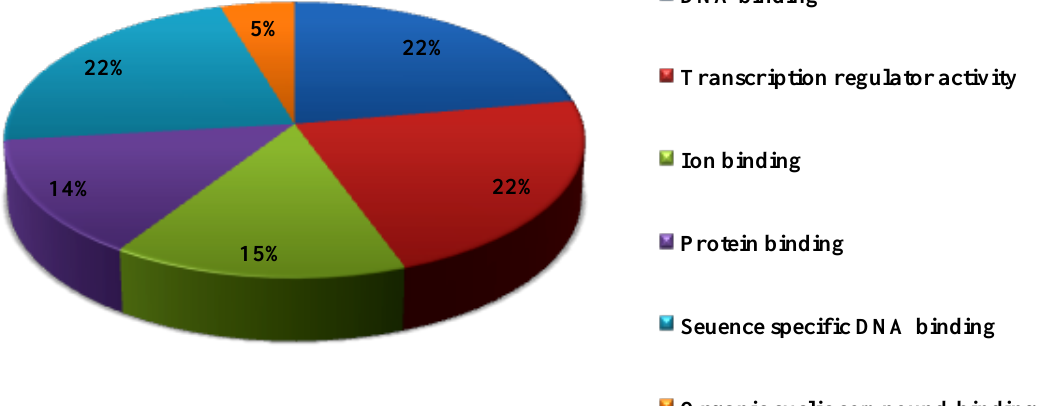
Figure 7. OsWRKY genes and their molecular function . The molecular function was imputed according to the significance level ( p -value FDR cut-off).